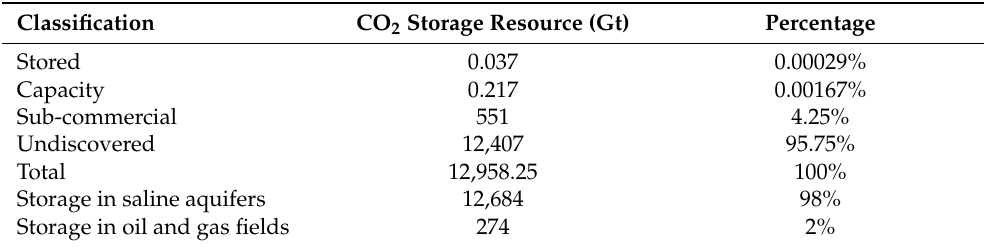
Table 2. Classification of CO 2 potential storage resources for the 17 countries (data source: CO 2 Storage Resource Catalogue Cycle 2 2021